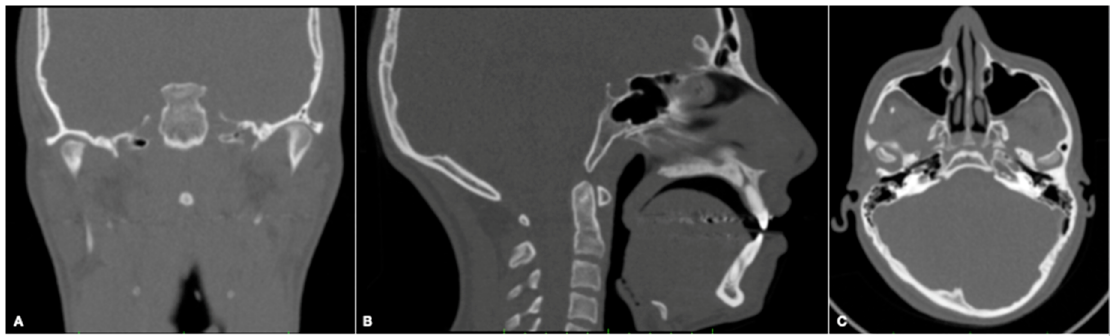
Figure 1. CT of a patient with left side condylar hyperplasia. ( A ) Coronal view. ( B ) Sagittal view. ( C ) Axial view.